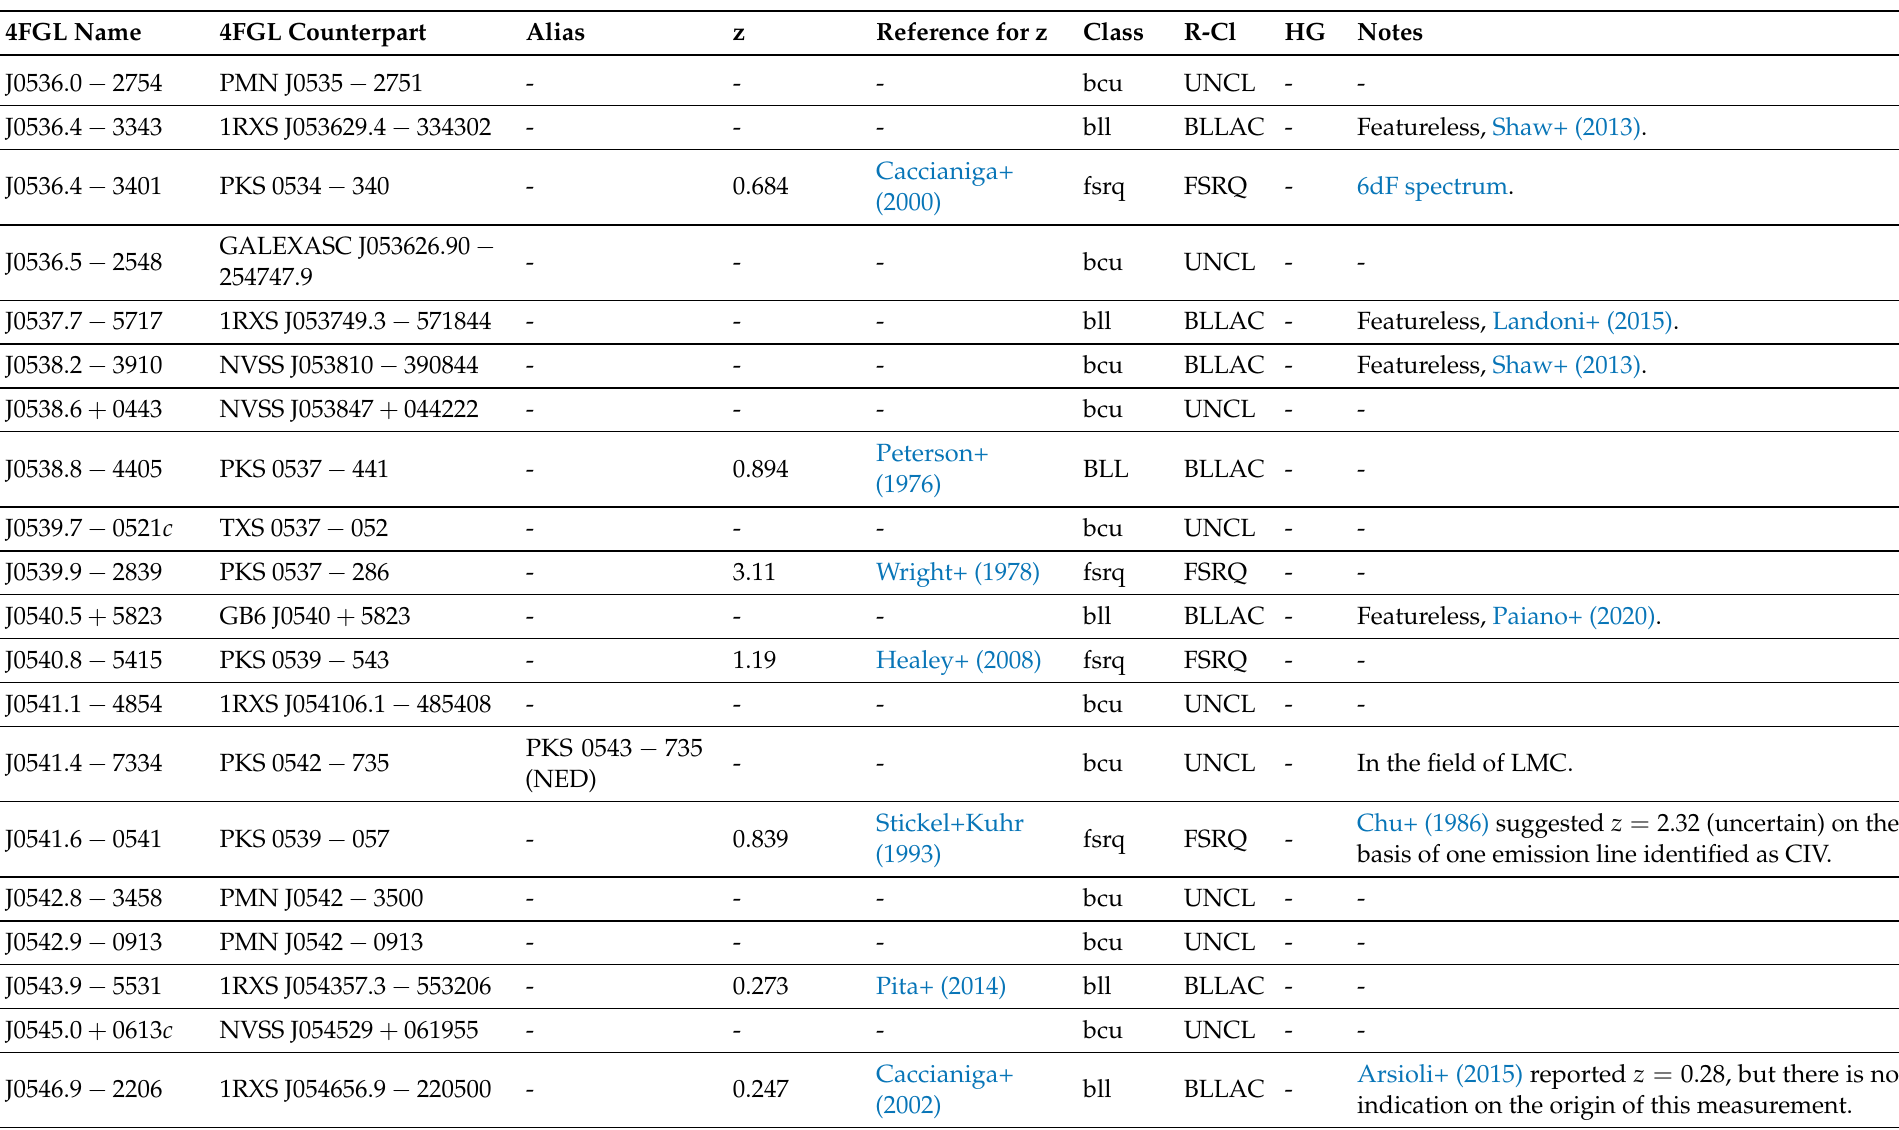
Arsioli+ (2015) reported z = 0.28, but there is no BLLAC - indication on the origin of this